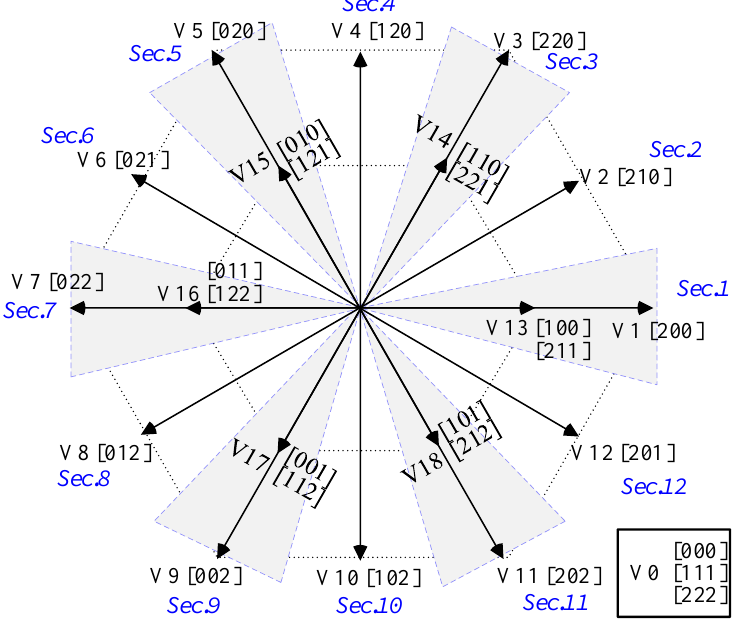
Figure 3. The proposed stator flux plane and the voltage vectors of a 3L